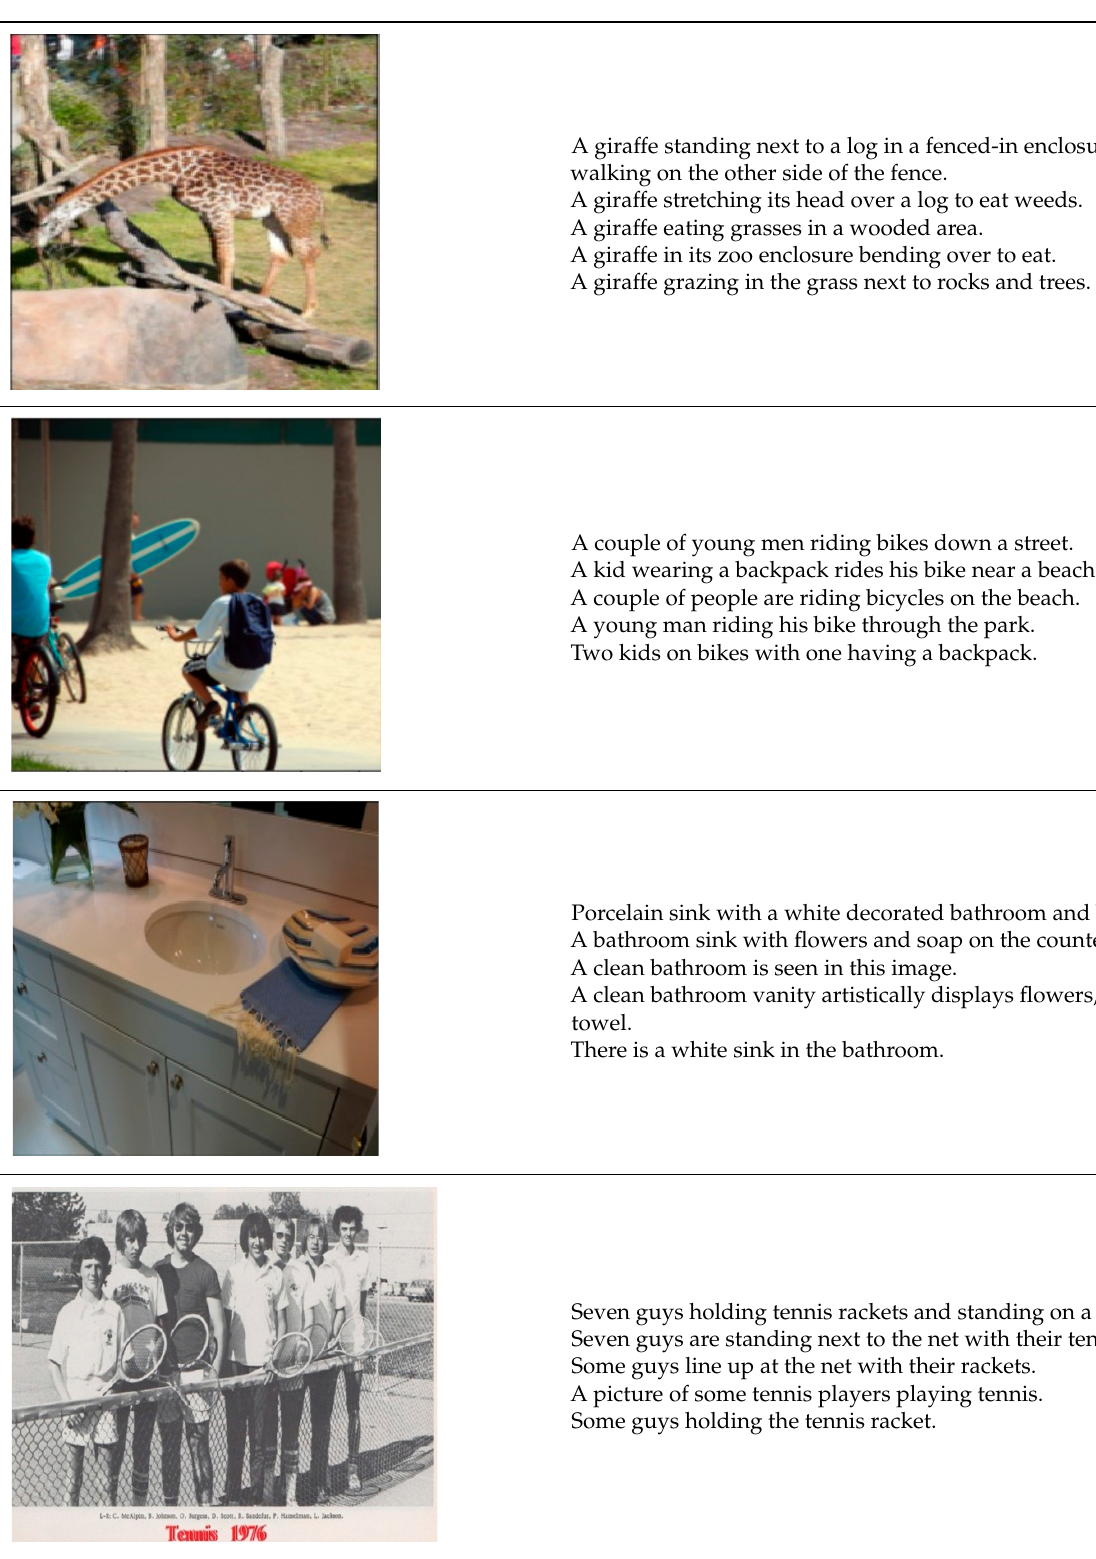
Table 1. Image captioning as given for various images in the Microsoft Common Objects in Context dataset.